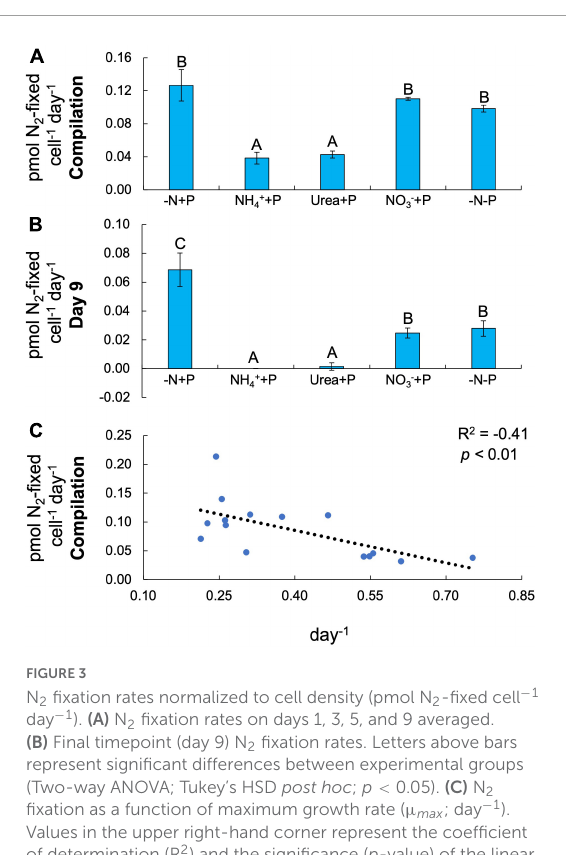
FIGURE3 N 2 fixation rates normalized to cell density (pmol N 2 -fixed cell − 1 day − 1 ). (A) N 2 fixation rates on days 1, 3, 5, and 9 averaged. (B) Final timepoint (day 9) N 2 fixation rates. Letters above bars represent significant differences between experimental groups (Two-way ANOVA; Tukey’s HSD post hoc ; p < 0.05). (C) N 2 fixation as a function of maximum growth rate ( µ max ; day − 1 ). Values in the upper right-hand corner represent the coefficient of determination (R 2 ) and the significance ( p -value) of the linear regression.